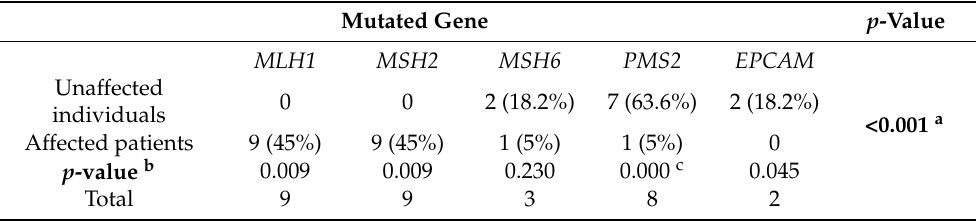
Table 2. Distribution of MMR genes variants in Affected and Unaffected